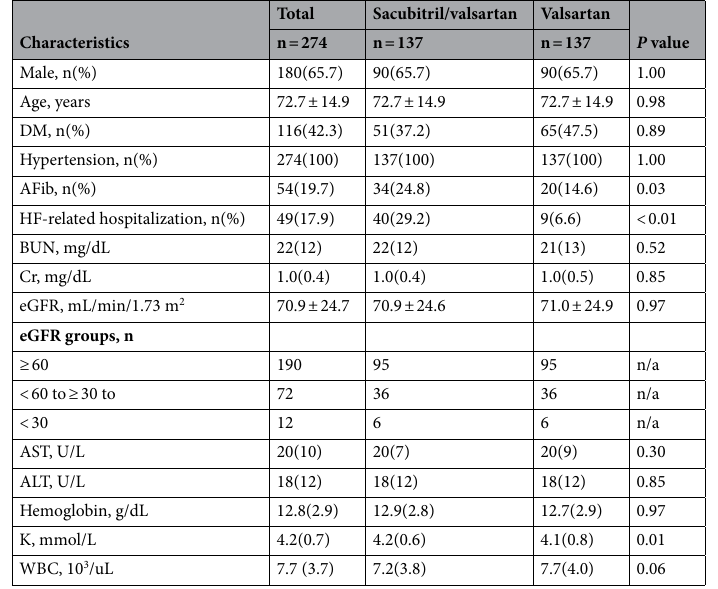
Table 1. Baseline demographic and laboratory characteristics. DM diabetes mellitus, AFib atrial fibrillation, HF heart failure, BUN blood urea nitrogen, Cr creatinine, eGFR estimated glomerular filtration rate, AST aspartate transaminase, ALT alanine transaminase, WBC , white blood cell.